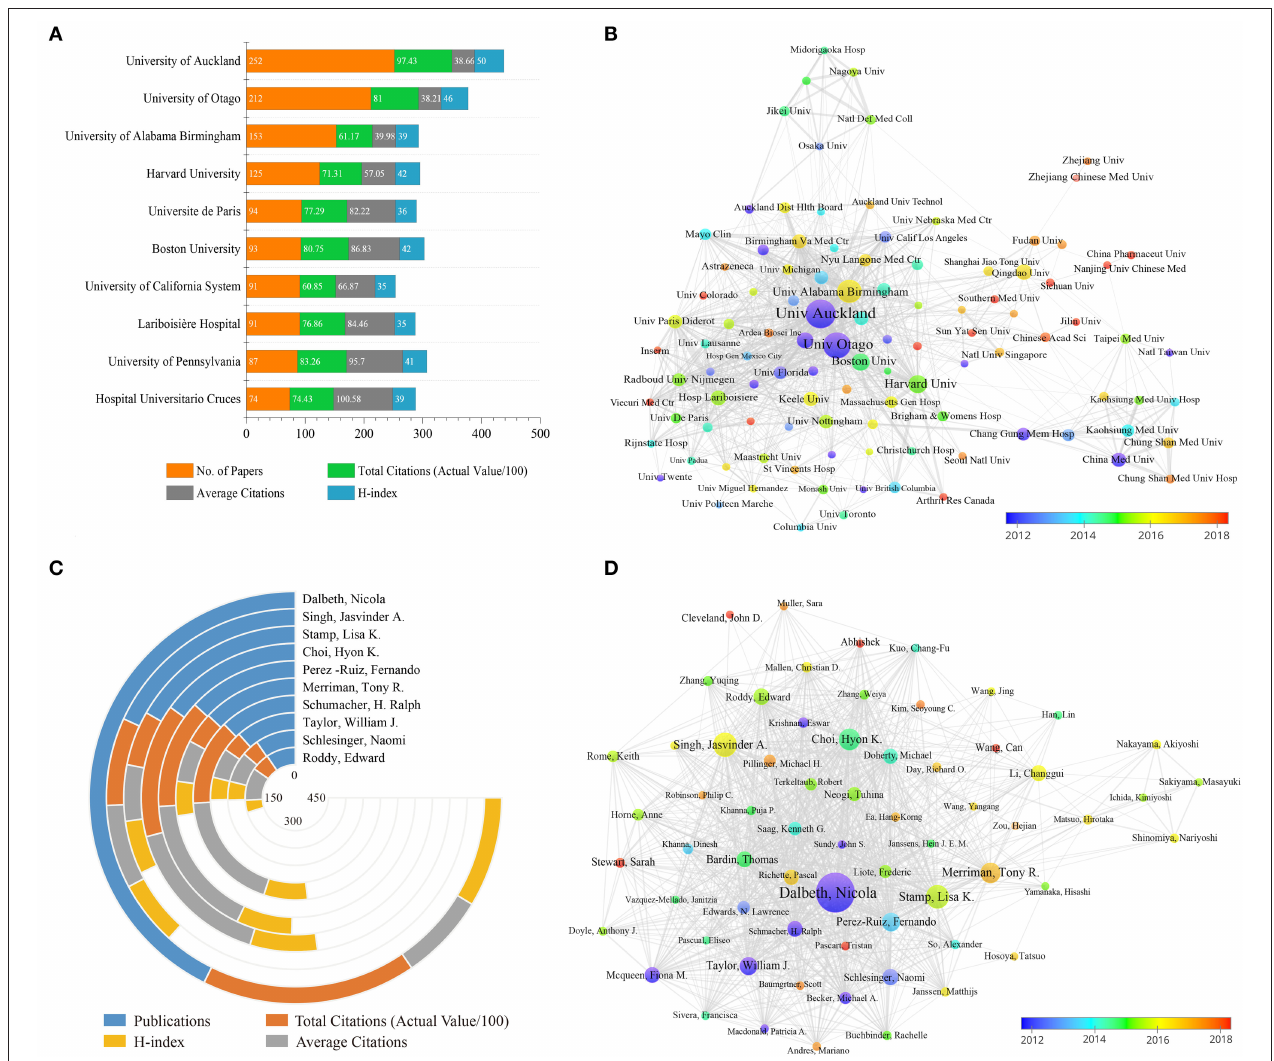
FIGURE 3 | (A) The publication counts, citations and H-index of the top 10 prolific institutions. (B) Cooperation network among institutions. (C) The publication counts and citations of the top 10 most productive authors. (D) Cooperation network among authors. The nodes in the graph represent institutions or authors, and lines between the nodes represent the collaborative relationships. Nodes are marked with different colors depending on the average appearing year. The thickness of lines between two institutions or authors indicates the strength of cooperation, while the area of nodes represents the number of